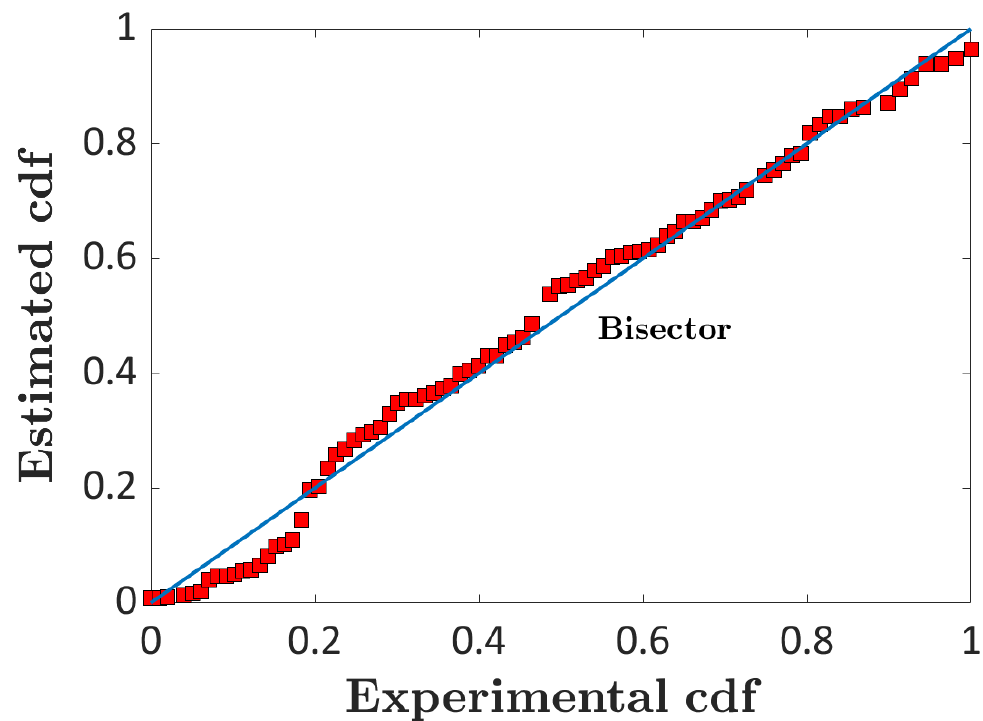
Figure 7. Probability-Probability (P-P) plot of the experimental data: estimated CDF with respect to the experimental CDF.